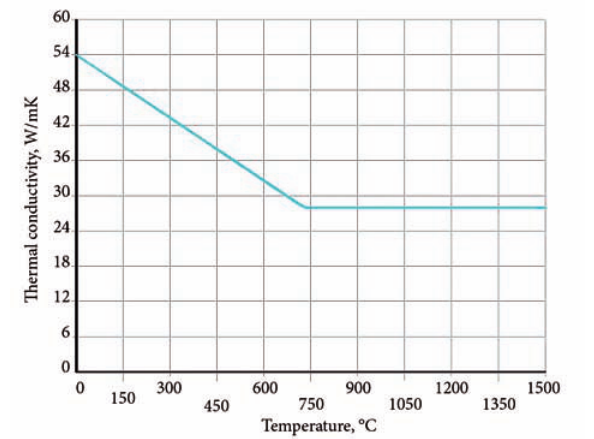
Fig. 3. Thermal conductivity reliance on temperature